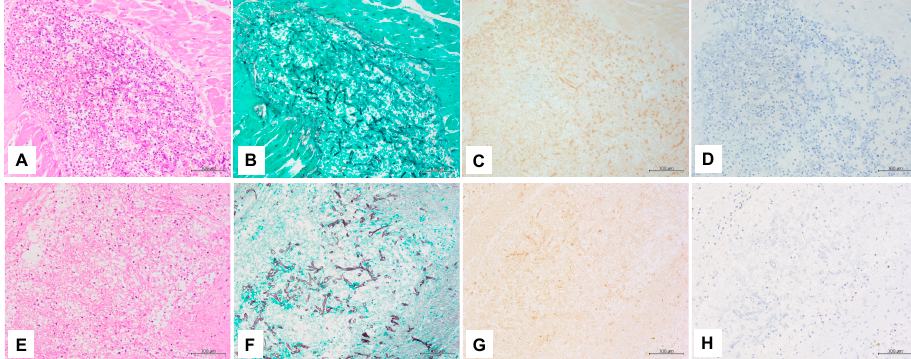
Figure 3. Immunohistochemistry findings: Pictures ( A – D ) were taken from the same heart area. Pictures ( E – H ) were taken from the same spleen area. Hematoxylin eosin (HE) staining ( A , E ), Grocott’s methenamine silver (GMS) staining ( B , F ), ( C ) Positive reaction for anti- Rhizopus arrhizus antibody. Brown staining of hyphae can be seen in the heart tissue. ( D ) Negative reaction for anti- Aspergillus antibody. ( G ) Positive reaction for anti- Rhizopus arrhizus antibody. ( H ) Negative reaction for anti- Aspergillus antibody. Magnification of all pictures are (200×).